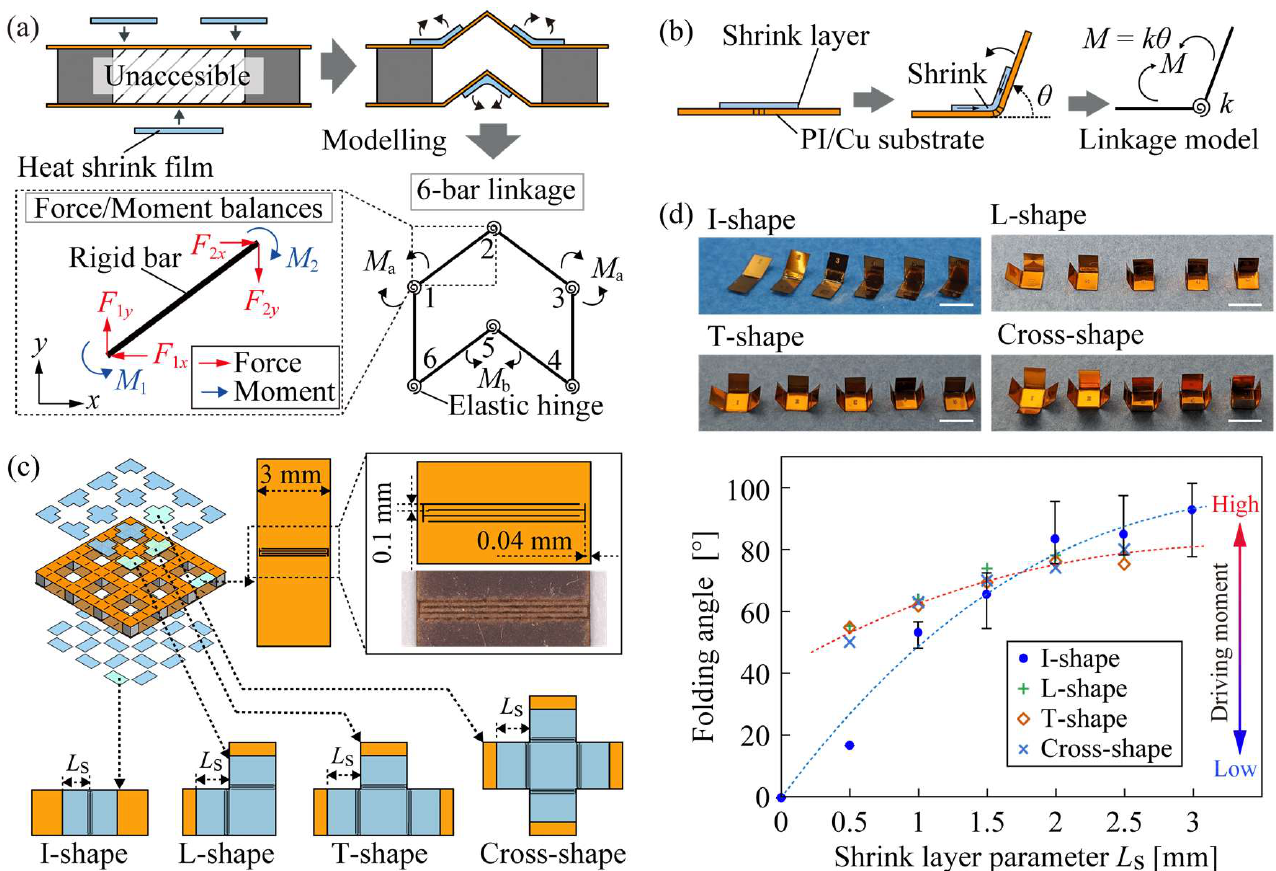
Figure 2. Design methods for self-folding using linkage mechanisms. ( a ) Modeling of a pair of origami-TEG. Force and moment analysis considering the linkage mechanism. ( b ) Modeling of hinges. ( c ) Design of hinge specimens and definition of shrink layer parameter L s . ( d ) Relationship between shrink layer parameter L s and folding angle θ for each hinge. Scale bar, 5 mm.